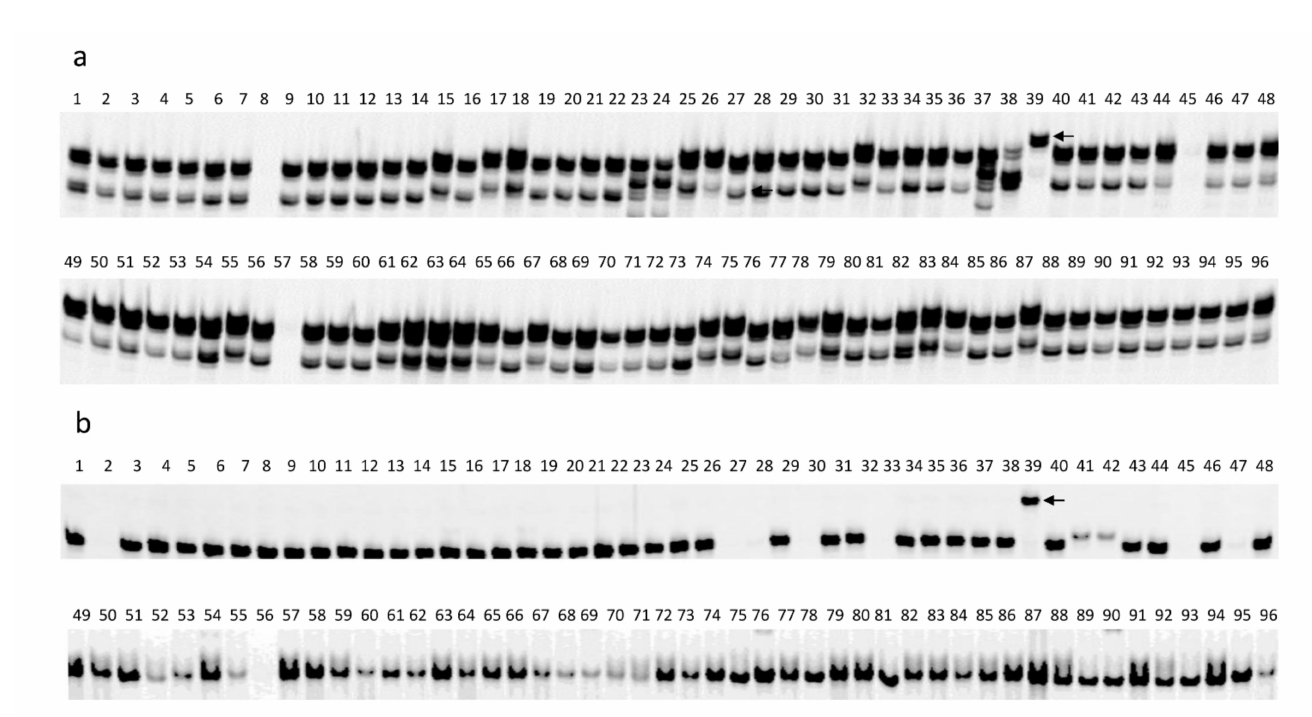
Figure 6. The polymerase chain reaction (PCR) amplification pattern of single nucleotide polymor- phism (SNP) markers in the 96 selected sunflower lines. The names and pedigrees of 96 selected sunflower lines (lanes) are listed in Supplementary Table S3. ( a ) SNP marker C13_194722668 diagnos- tic for R 16 , the arrow indicates the amplified band corresponding to C13_194722668- R 16 marker allele which is only present in the TX16R line in lane 39. ( b ) SNP marker C4_5671004 diagnostic for Pl 33 , the arrow indicates the amplified band corresponding to C4_5671004- Pl 33 marker allele which is only present in the TX16R line in lane 39. Lane 39: TX16R with R 16 and Pl 33